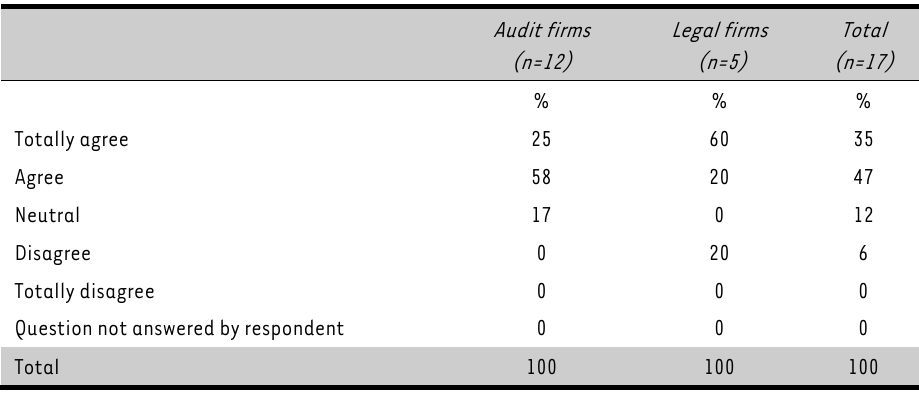
Results of question